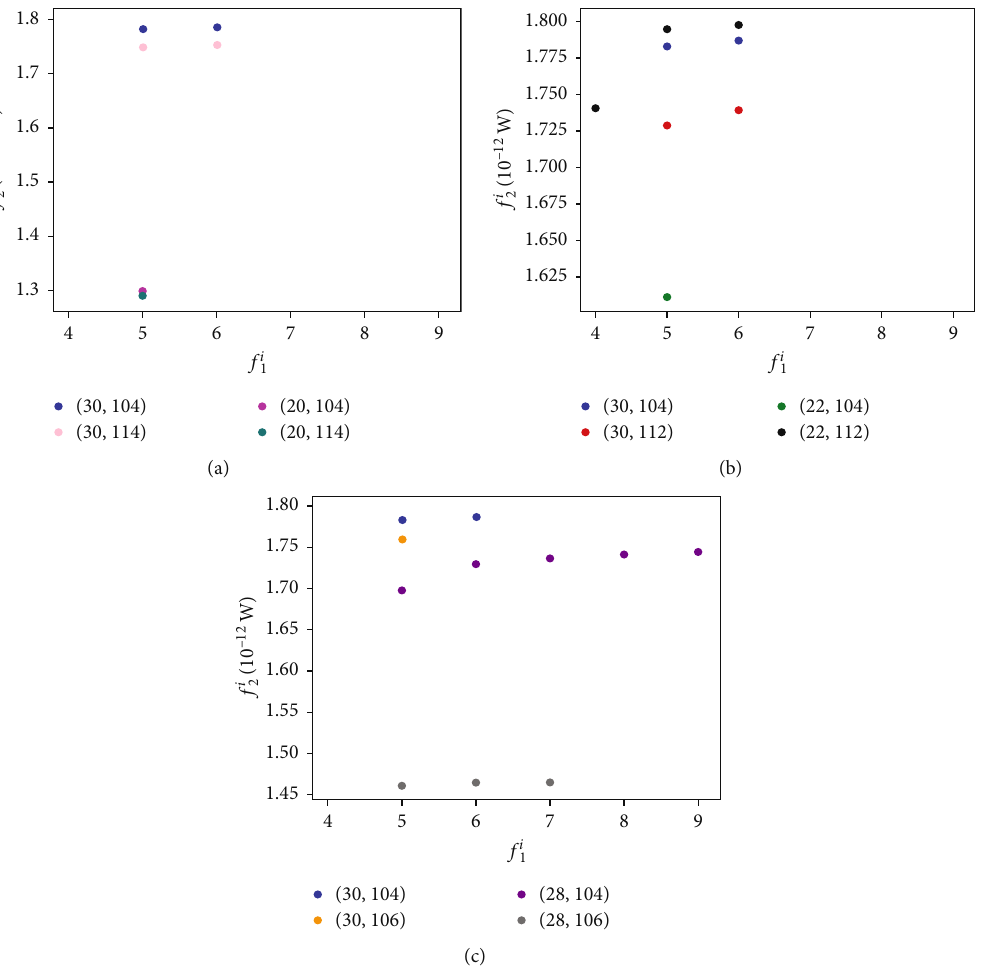
Figure 5: The initial Pareto front of users with di ff erent density levels of users: (a) sparse; (b) general; (c)